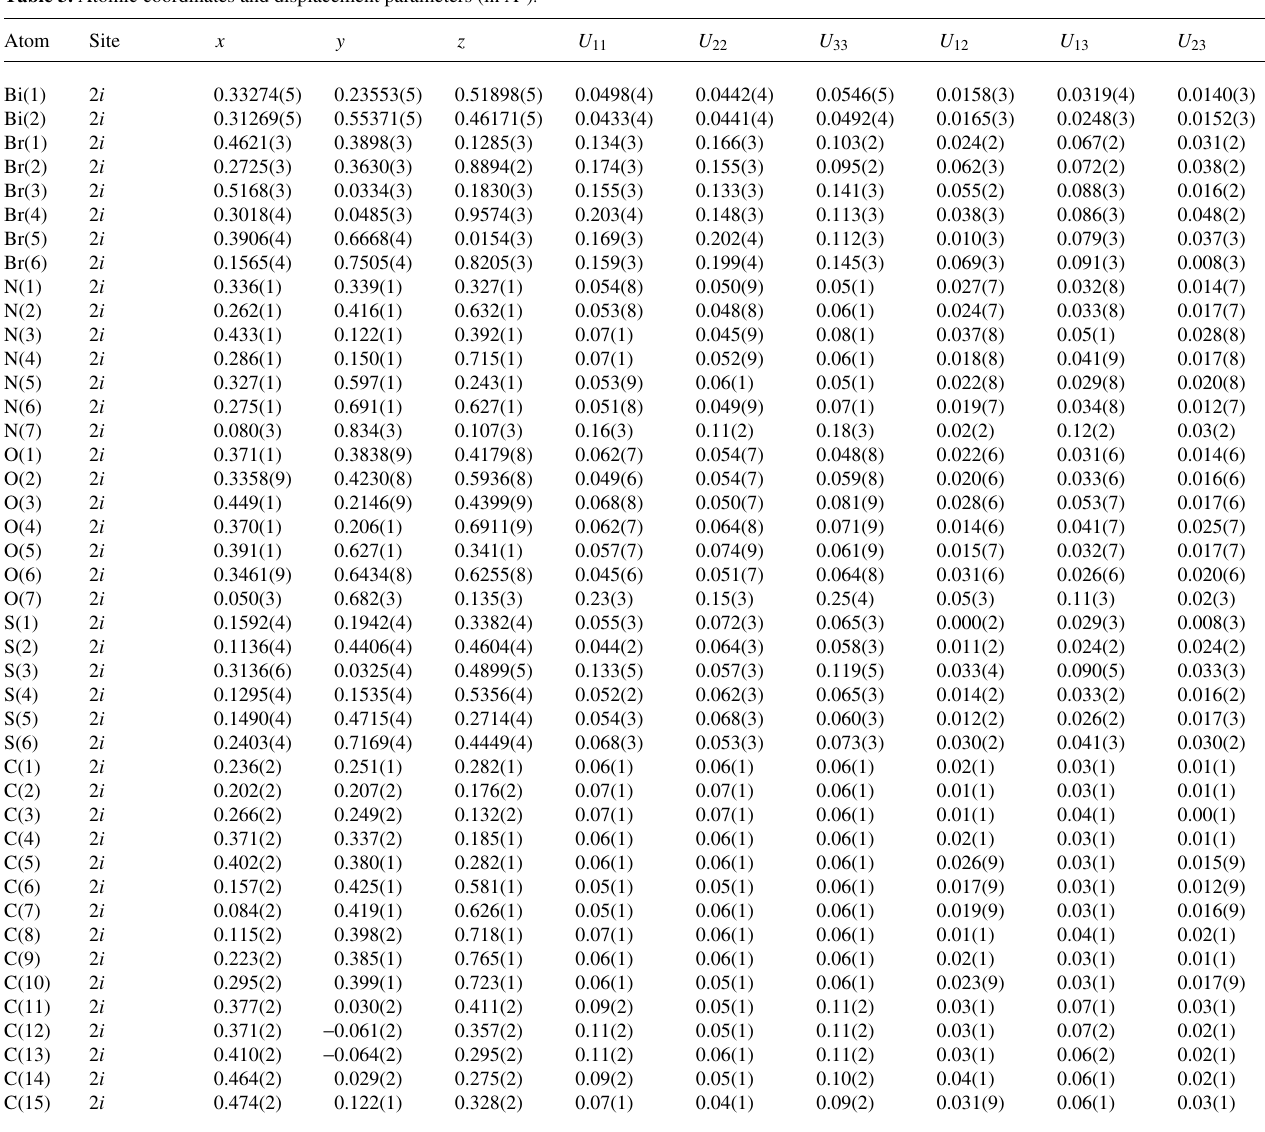
Table 3. Atomic coordinates and displacement parameters (in Å 2 ) .